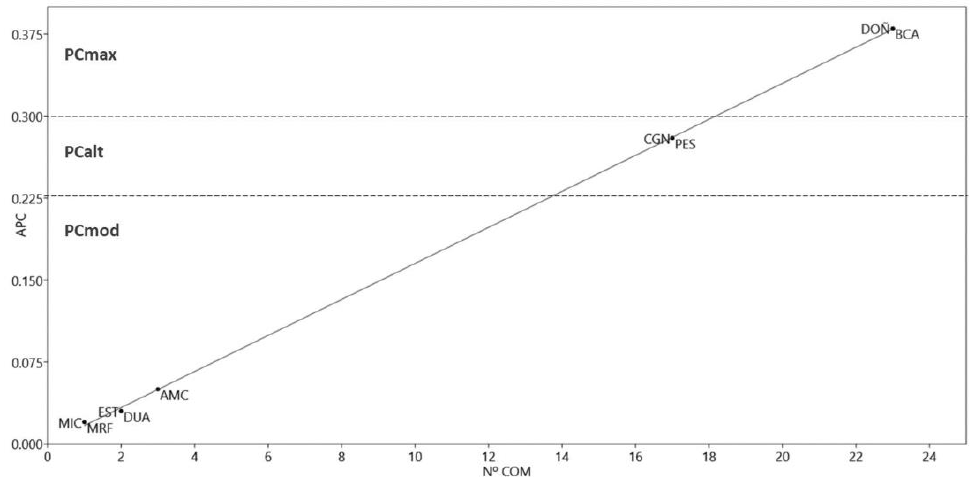
Figure 3. Distribution of Protected Areas (PAs) based on the values of the conservation priority index (PCA) and the number of communities (No. COM). PCmax, Highest priority; PCalt, High priority; PCmod, Moderate priority; AMC, Acantilados de Maro-Cerro Gordo; BCA, Bah í a de Cadiz; CGN, Cabo de Gata-Nijar; DOÑ, Doñana; DUA, Dunas de Artola; EST, Estrecho; MIC, Marismas de Isla Cristina; MRF, Marismas de R í o Piedra and Flecha del Rompido; PES, Punta